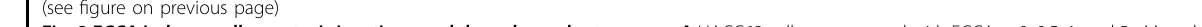
Fig. 2 ECCA induces cell apoptosis in a time- and dose-dependent manner. A UACC62 cells were treated with ECCA at 0, 0.5, 1, and 5 µM, and at 12 h cells were collected and analyzed for cell apoptosis by FACS analysis. B Quanti fi cation of the percentage of the apoptotic cells in A . C Mel-Juso cells were treated with ECCA at 0 or 10 µM and at 12 h, cells were collected and analyzed for cell apoptosis by FACS analysis. D Quanti fi cation of the percentage of the apoptotic cells in C . E UACC62 cells treated with or without various concentrations of ECCA were lysed at different time points as indicated and immunoblotting analysis was performed for total and cleaved forms of Caspase8, -9, -3, and PARP. GAPDH as a housekeeping gene was used as a loading control. Red, green, blue, and black arrows, respectively, indicate the upregulated expression of cleaved (c) forms for PARP (c-PARP), Caspase8 (c-Caspase8), Caspase9 (c-Caspase9), and Caspase3 (c-Caspase3). F Quanti fi cation of the relative levels of c-Caspase8, c-Caspase9, c- Caspase3, and c-PARP in E , as relative fold change to the respective control cells, indicated by a dashed line as 1, after each phosphorylated protein was normalized to the corresponding total protein band. G UACC62 cells were treated with different conditions: DMSO (control), 10 µM z-VAD-FMK, 1 µM ECCA, z-VAD-FMK (10 µM) + ECCA (1 µM), 5 µM ECCA, z-VAD-FMK (10 µM) + ECCA (5 µM), and after 12 h, cells were collected and analyzed for cell apoptosis by FAC analysis. H Quanti fi cation of apoptotic cell percentage in G . All experiments were carried out three times, and error bars represent means + SD; P values are indicated with “ * ” , * indicates P < 0.05, ** indicates P < 0.01 when comparing ECCA-treated cells with the control group in B , D , F , and H by Student ’ s t test; Lines in H indicate comparisons of two speci fi c